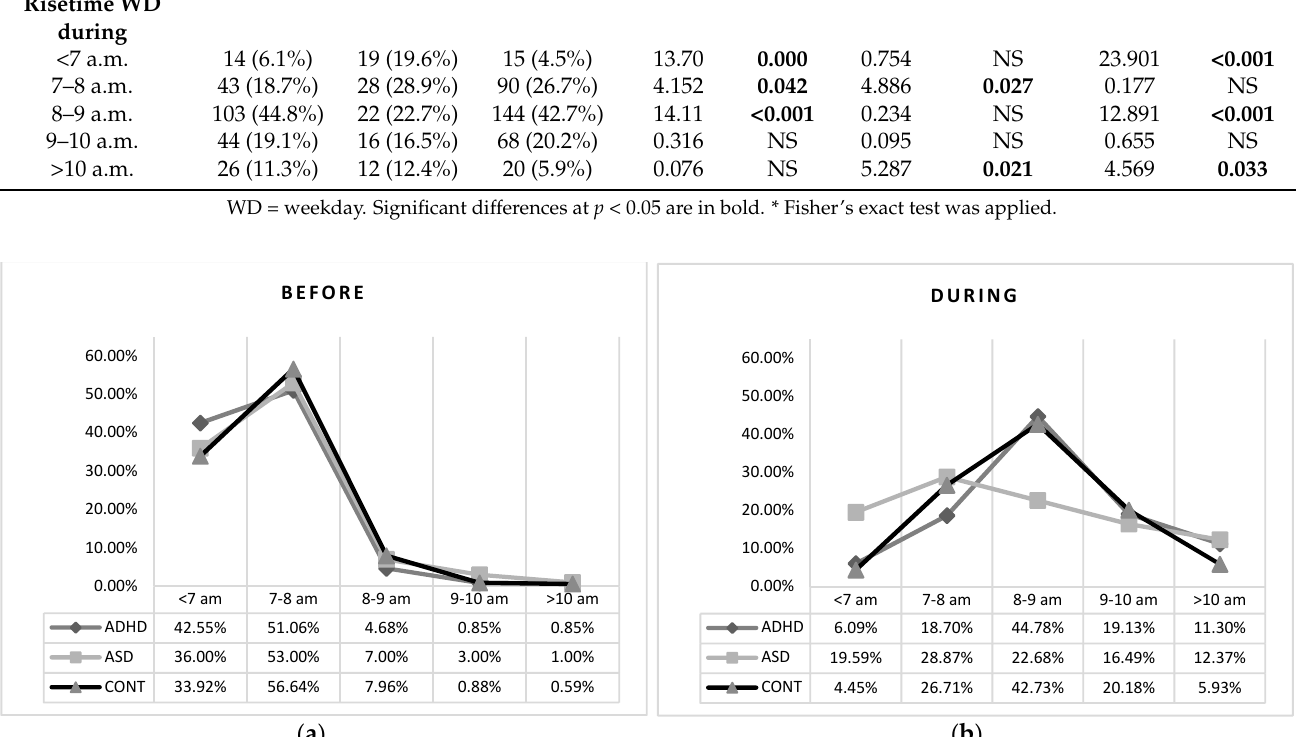
Table 4. Comparison between sleep duration in weekdays before and during lockdown in the three groups. ADHD vs. ASD ADHD vs. Controls ASD vs. Controls